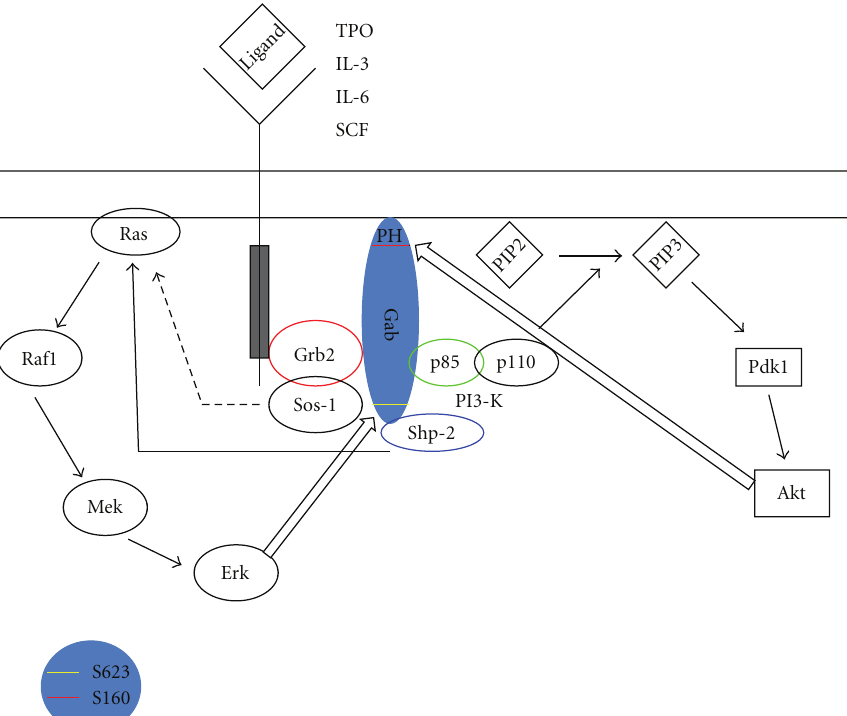
Figure 2: Gab2 interactions with binding partners. Diagram shows generic Gab adapter docked at the plasma membrane by the PH domain. Interactions with p85 and SHP-2 are involved in Akt and Erk activation respectively. Binding of receptor tyrosine kinases to their receptive ligands triggers the kinase activity of the cytoplasmic domain of the receptor. The receptor becomes phosphorylated on tyrosine residues. Docking proteins such as Grb2 contain SH2 domains that bind to the phosphotyrosine residues of the activated receptor. Grb2-Gab interacts through the SH3 domains and activates downstream signaling pathways, PI-3K/Akt and SHP2/Erk. Grb-2 can bind to SOS via N-terminal SH3 domain while the C-terminal SH3 domains are used for its interaction with Gab proteins. SOS-1 has been known to associate with Grb2, leading to its autophosphorylation. This complex gets translocated to the activated receptor where it then associates with Ras. As Ras gets activated it induces the downstream ERK/MAPK pathway. Alternatively, stimuli from growth factors like EGF, VEGF, and so forth, causes binding of Gab2 to Grb2. This then leads to recruitment of SHP2, that binds to phosphorylated tyrosine residues on Gab, and in turn activates ERK/MAPK signaling. Negative feedback by serine phosphorylation of Gab at S160 by Akt and S623 by Erk (block arrows) plays an important role in control of function and signaling of